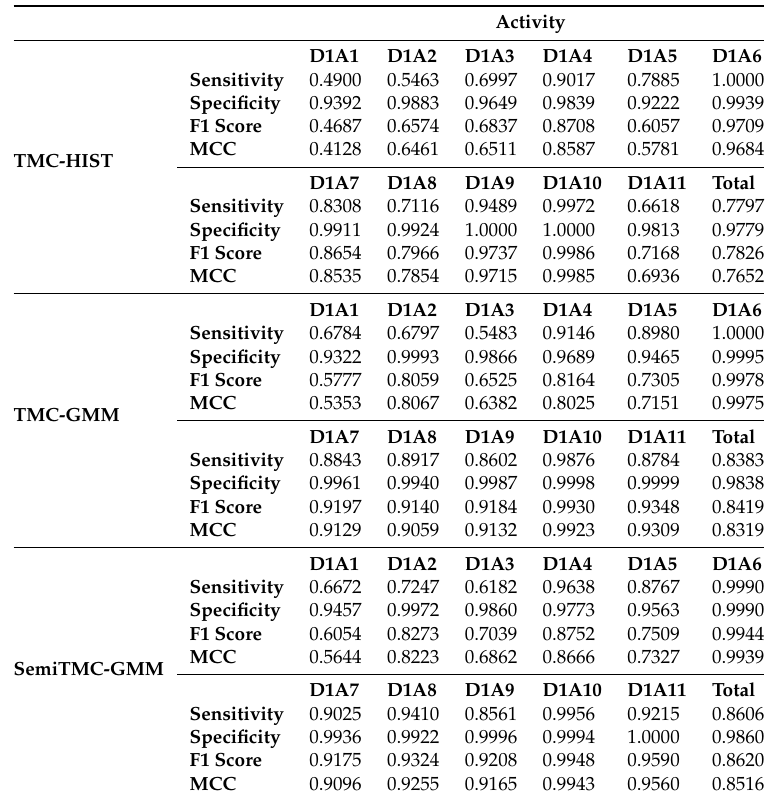
Figure 4. The batch mode recognition performance of the Sports and Daily Activities (SDA) dataset, of the SemiTMC-GMM, and TMC-GMM models, according to different GMM mixture number κ . ROC = Receiver Operating Characteristics. Table 1. The sensitivity, specificity, F1 score, Matthews correlation coefficient (MCC) value of the batch mode recognition, for each activity of SDA dataset, using the sensor placed on right thigh. Up : TMC-HIST; middle : TMC-GMM when κ = 6; and down : SemiTMC-GMM when κ =